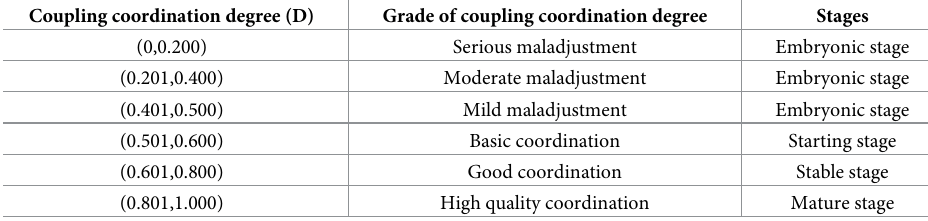
Table 1. The grade division of coupling coordination